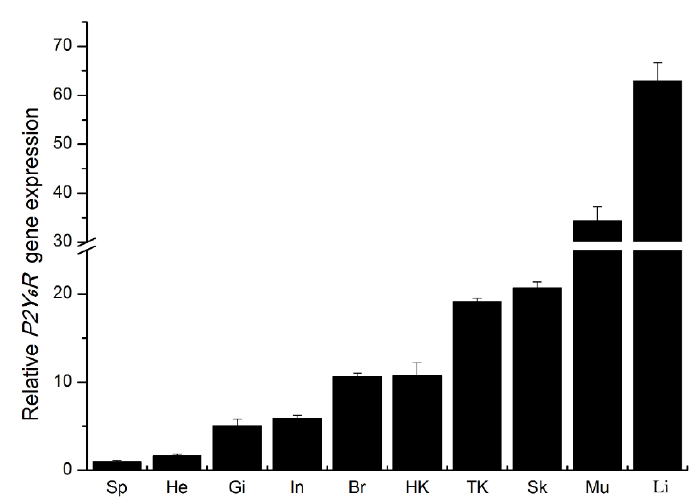
Figure 3. Quantitative real ‐ time RT ‐ PCR analysis of basal expression of P2Y 6 receptor mRNA transcripts in Japanese flounder tissues. Individual tissues from five healthy Japanese flounders were equally pooled for quantification of the relative gene expression level of P2Y 6 R with β‐ actin as an internal reference gene. Abbreviations for x ‐ axis: Sp: spleen; He: heart; Gi: gill; In: intestine; Br: brain; HK: head kidney; TK: trunk kidney; Sk: skin; Mu: muscle; Li: liver. Data represent means ± standard deviations from triplicate experiments.